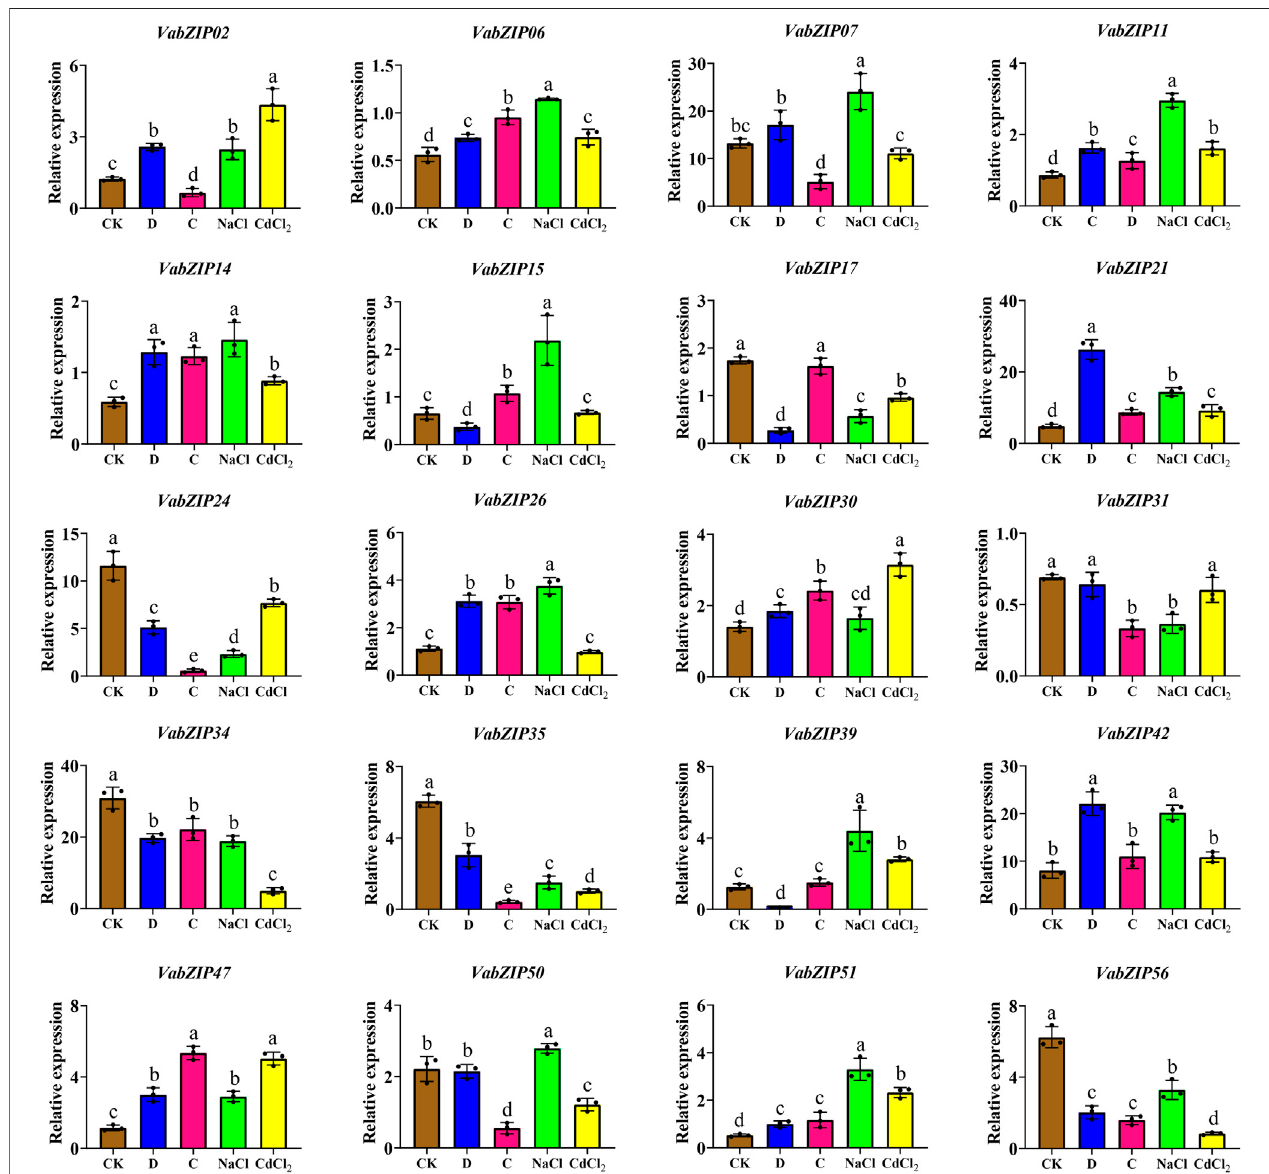
FIGURE 9 | Relative expressions of VabZIPs in radicles under different abiotic stress levels at the bud stage. Brown squares denote CK treatment, whereas the blue, pink, green, and yellow squares denote drought, cold, salt, and heavy metal stress, respectively.